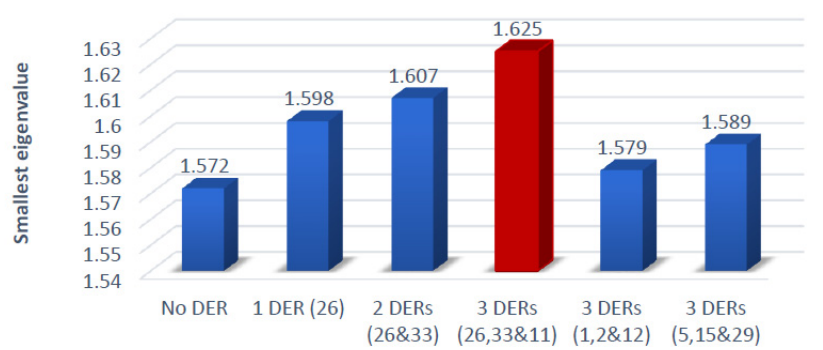
Figure 8. The system’s smallest eigenvalue comparison.